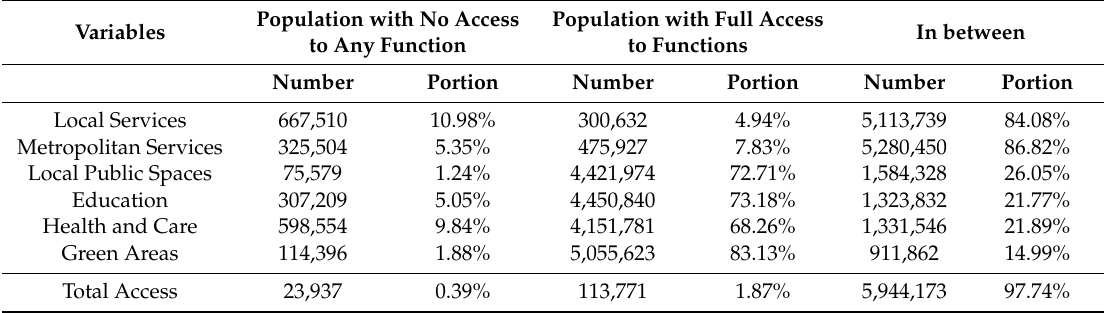
Table 4. Results of the assessment of access to functions in the Santiago Metropolitan Area per each principal component. Source: